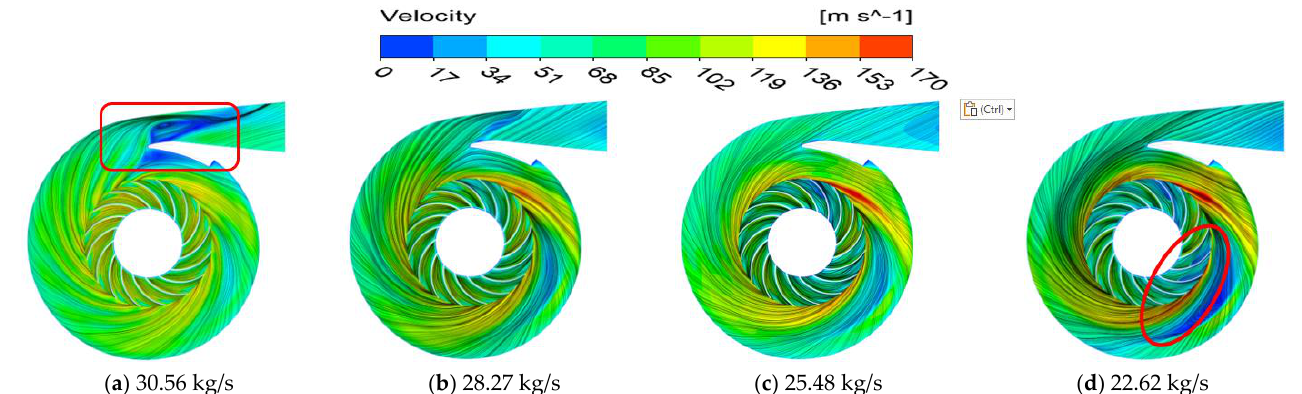
Figure 5. Distribution of the velocity and streamline in the Z = − 12mm section at different mass-flow rates .